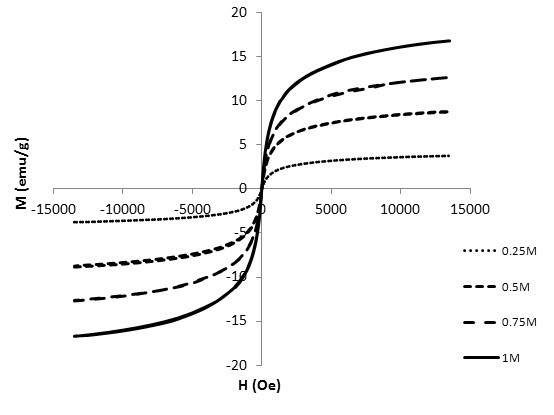
The magnetized curve of the Fe3O4 nanofluid measured by a VSM.